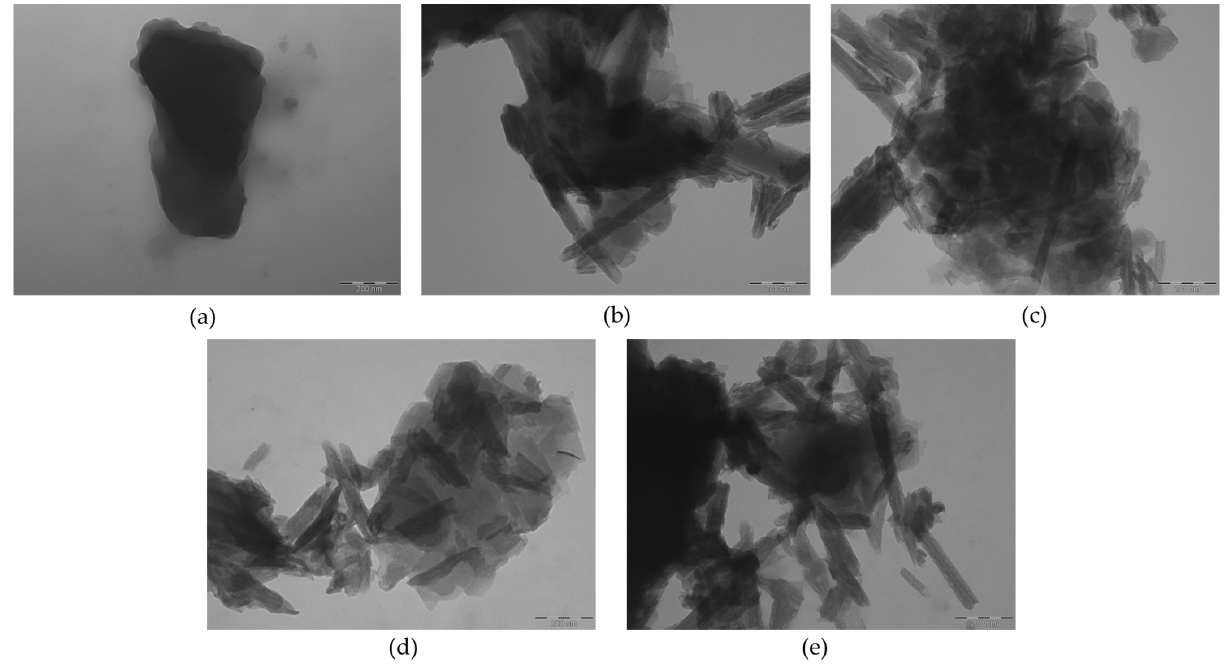
Figure 9. TEM images at 100 kX magnification of C ( a ), CH ( b ), CH_HCl_8M ( c ), CH_H 2 SO 4 _0.5M ( d ), and CH_NaOH_0.5M ( e ).